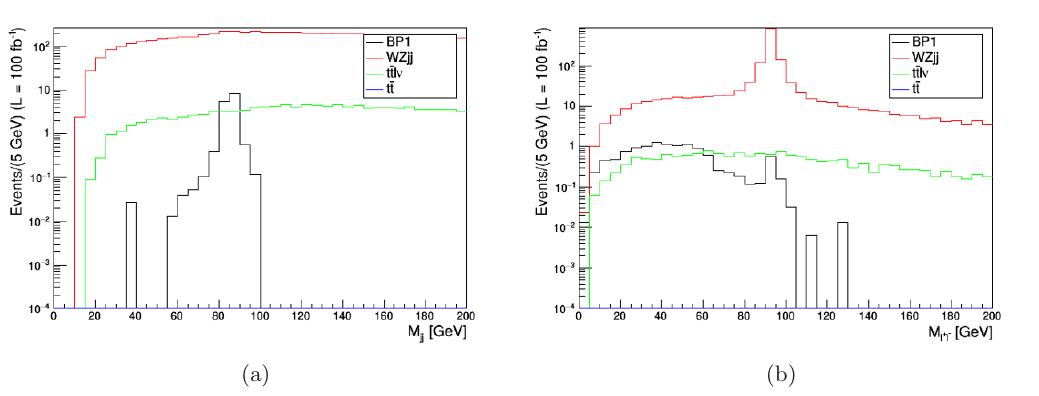
Figure 6 . (a) Distribution in the di-jet invariant mass for the benchmark point BP1. Acceptance cuts are applied. (b) Distribution in the di-lepton invariant mass for the benchmark point BP1. Acceptance cuts and M jj M W < 20 GeV are applied. A luminosity | − |